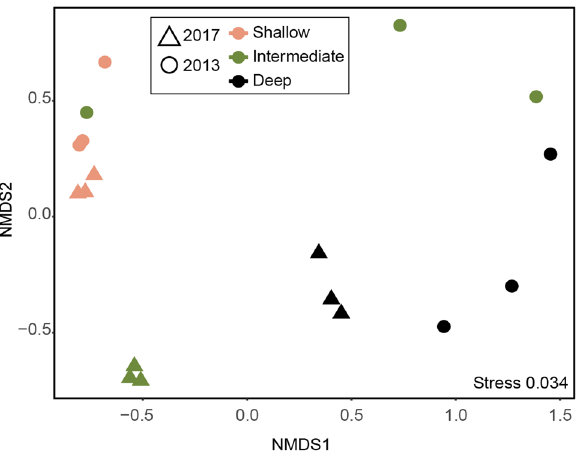
Figure 2. Non-metric multidimensional scaling (nMDS) plot of bacterial sediment communities. NMDS plot showing bacterial communities within each site ( n = 3) and year ( n = 2) based on all ASVs. The samples are colored by site (shallow (salmon), intermediate (green), and deep (black)) and years are separated by different symbols (2013 (circle) and 2017